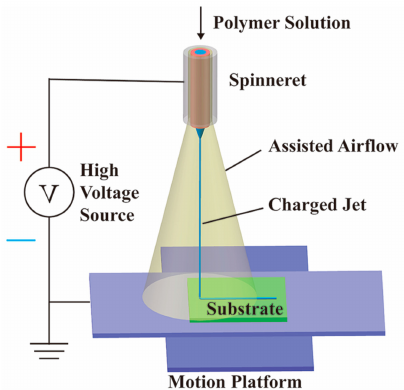
Figure 1. Schematic diagram of electrohydrodynamic direct-writing (EDW) with assisted airflow. To optimize jet behavior from the airflow-assisted spinneret, it was found that one major parameter was the vertical distance between the gas outlet and the liquid outlet ( L ), as presented in Figure 2a.